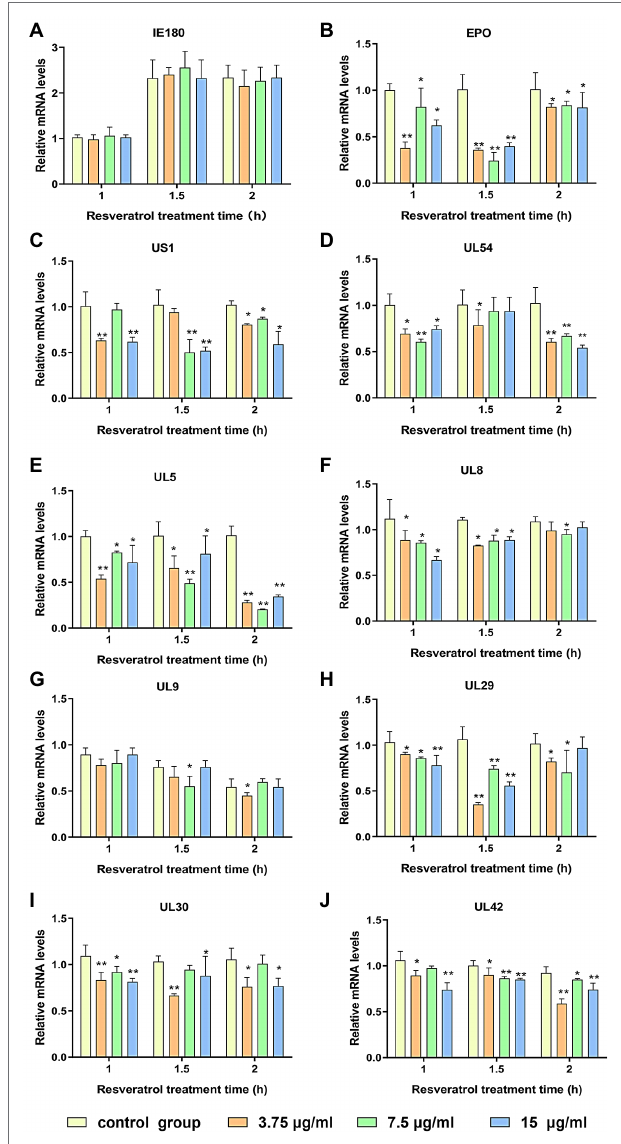
FIGURE 1 | Res inhibit the expressions of pseudorabies virus (PRV) genes. Gene expression levels of PRV were quantified by RT-PCR at 1, 1.5, and 2 h in the presence or absence of Res (3.75, 7.5, and 15 μ g/ml, respectively). (A) Effect of Res on the mRNA expression level of immediate early gene IE180. (B–D) Effects of Res on mRNA expression levels of early genes. (E–J) Effect of Res on mRNA expression levels of genes necessary for PRV replication. Values are presented as means ± SD ( n = 3), * p < 0.05 vs. control group; ** p < 0.01 vs. control